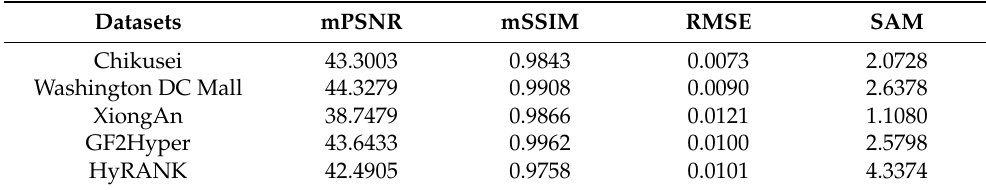
Table 4. Quantitative results of pre-trained model by random masking strategy with 90% masking rate. The model is trained with a 90% masking rate.